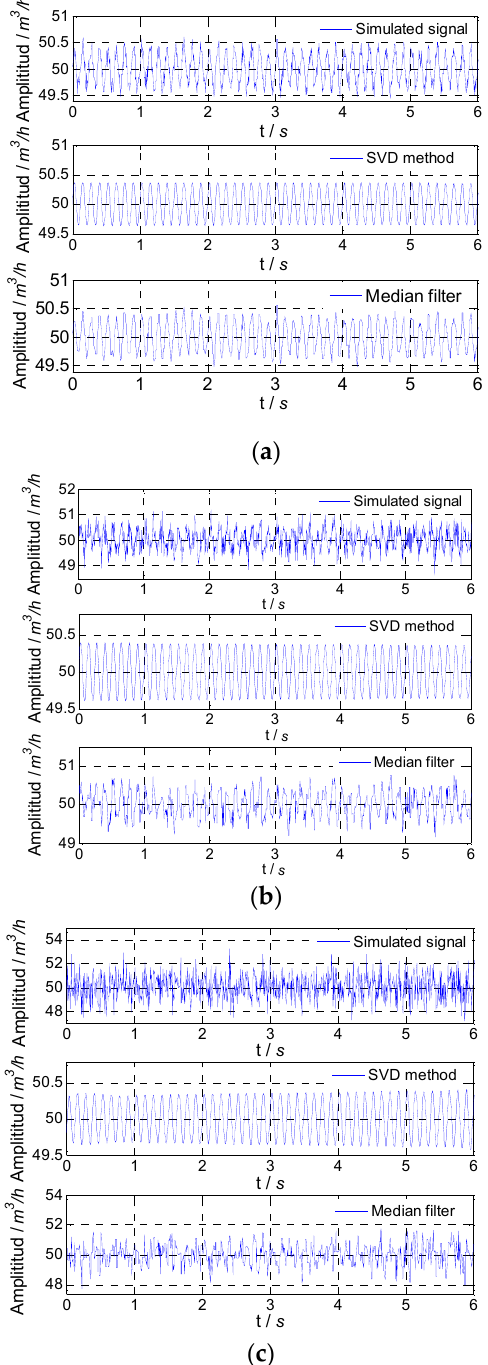
Figure 4. Simulated result for 8 Hz signal: ( a ) noise variance, 0.01; ( b ) noise variance, 0.1; ( c ) noise variance, 1. Table 2. Amplitude attenuation and SNR improvement for 8 Hz signal.